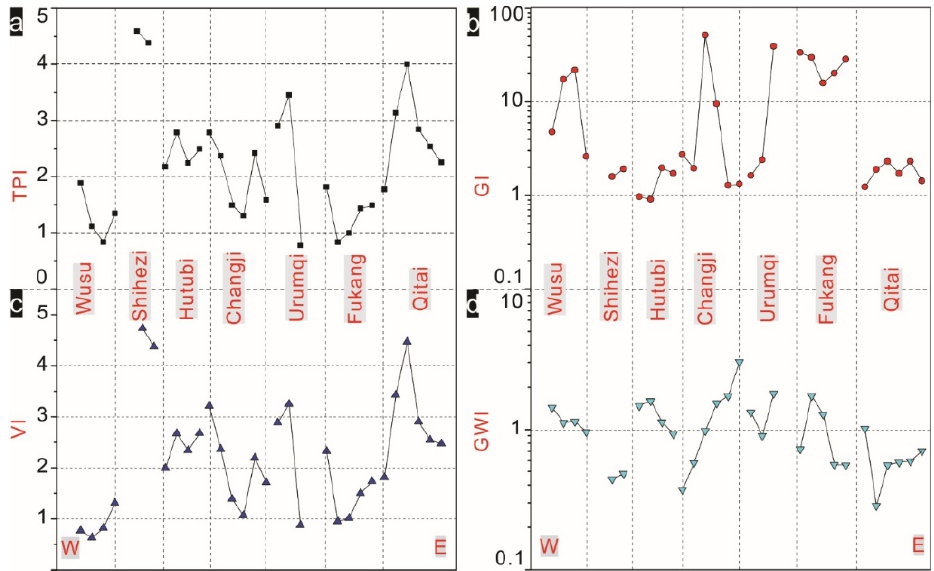
Figure 7. Lateral W–E variation of coal facies indices (( a ) TPI, ( b ) GI, ( c ) VI, ( d ) GWI) within the coal seams of the southern Junggar Coalfield.